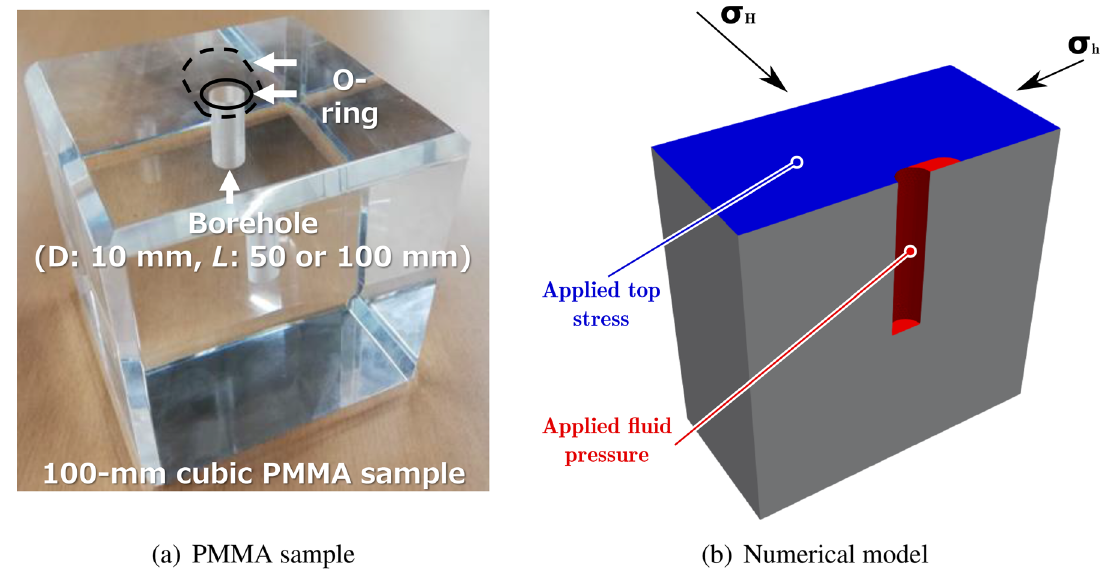
Figure 12. Sample of PMMA ( a ) and configuration of test P1 ( b ) with a bottom well and an a-symmetric o-ring that generates an additional stress concentration on one side of the